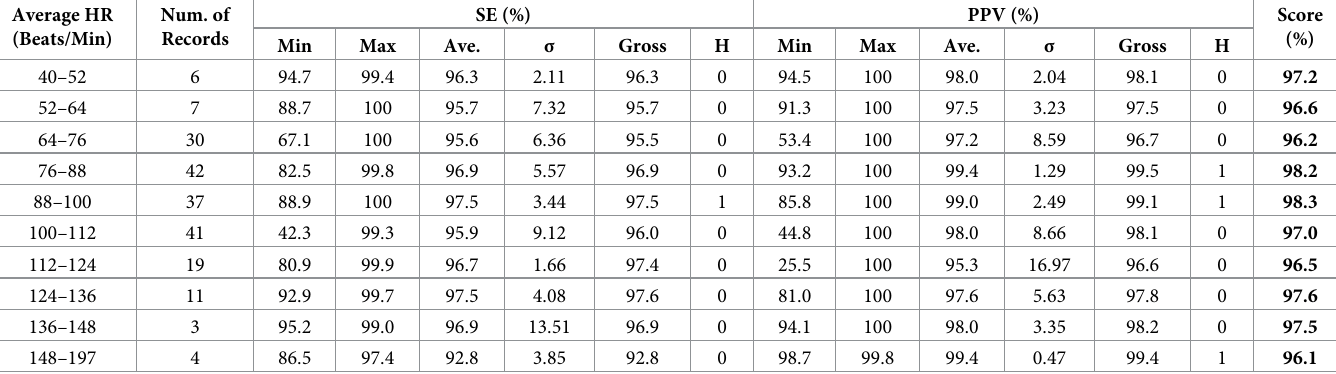
Table 6. Performance scores of MGH/MF waveform database grouped by average heart rate (HR). Average HR Num. of (Beats/Min)